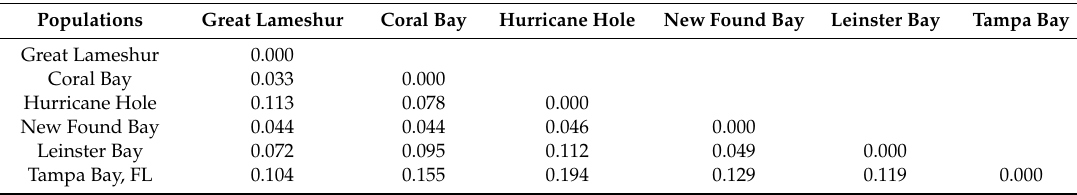
Table 3. Mangrove pair-wise population F ST values (via allelic frequency).